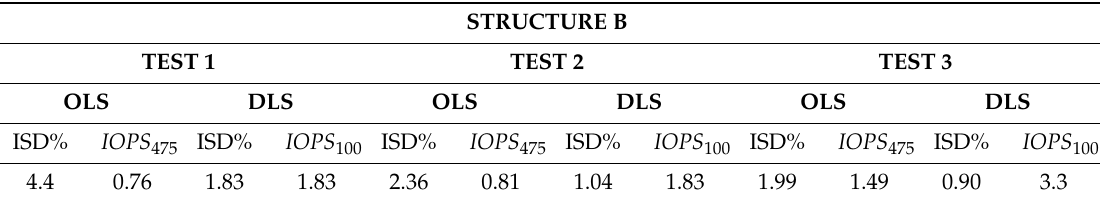
Table 14. Maximum Interstory Drift (ISD) % and operativity indicators IOPS 475 and IOPS 100 for OLS and DLS.